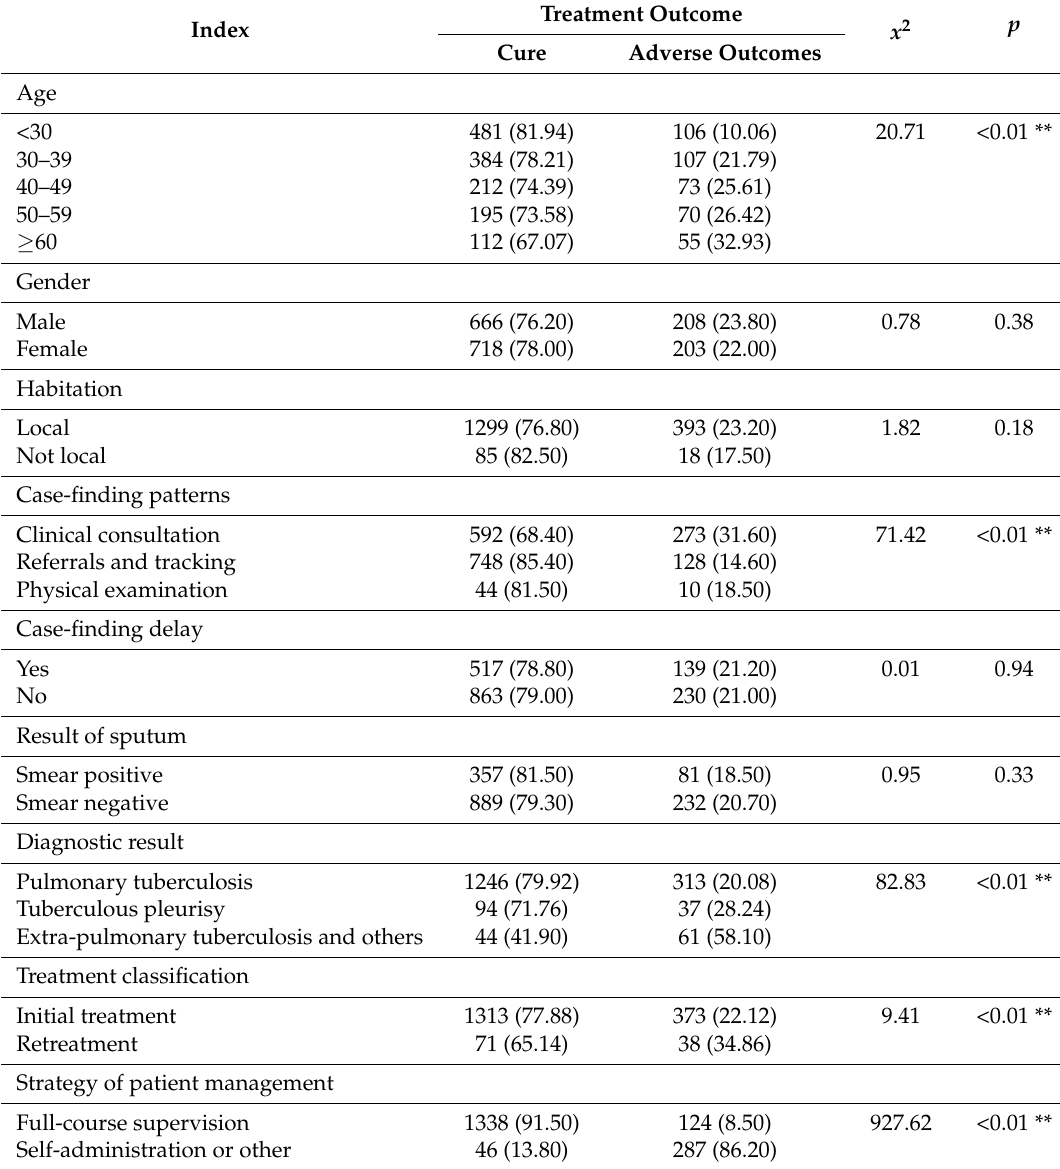
Table 3. Univariate analysis of treatment outcomes among full-time teachers with